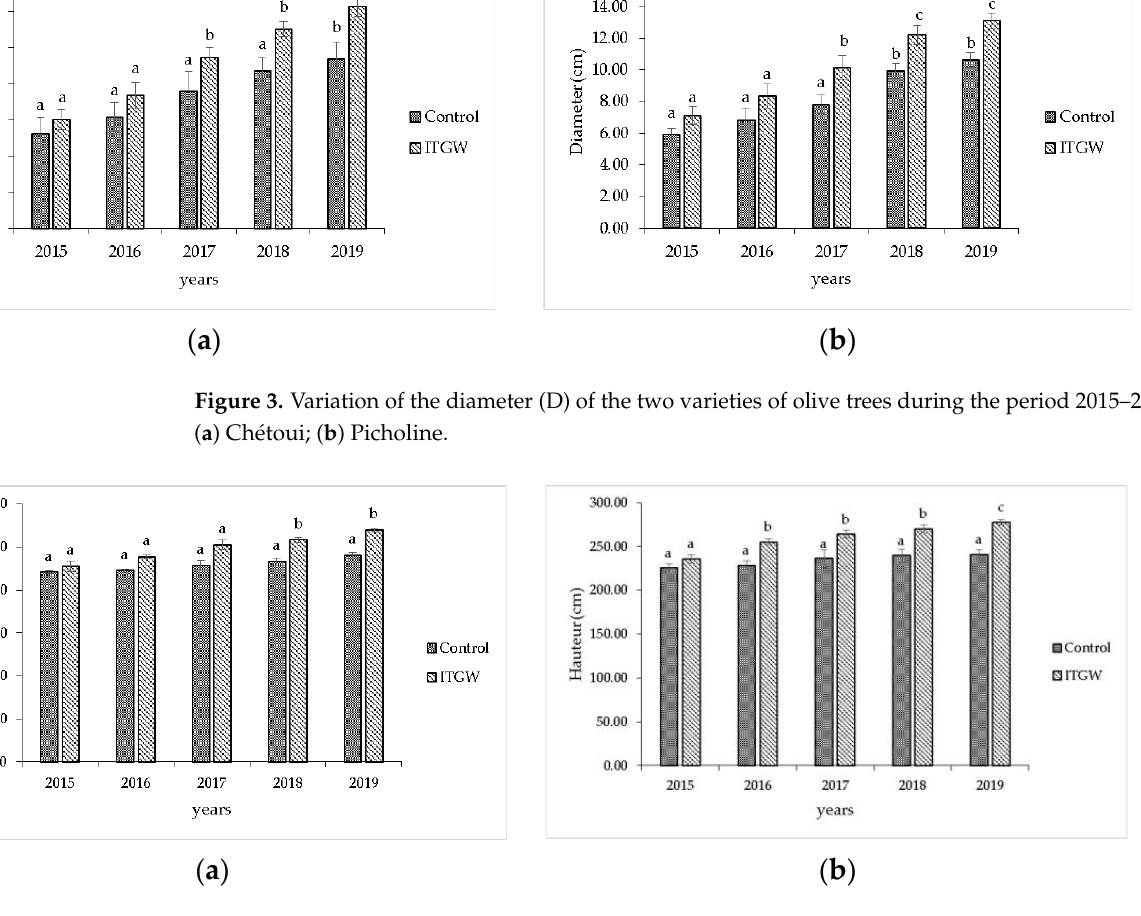
Table 3. Production (kg) of olive varieties conducted under TGW irrigation and natural conditions.